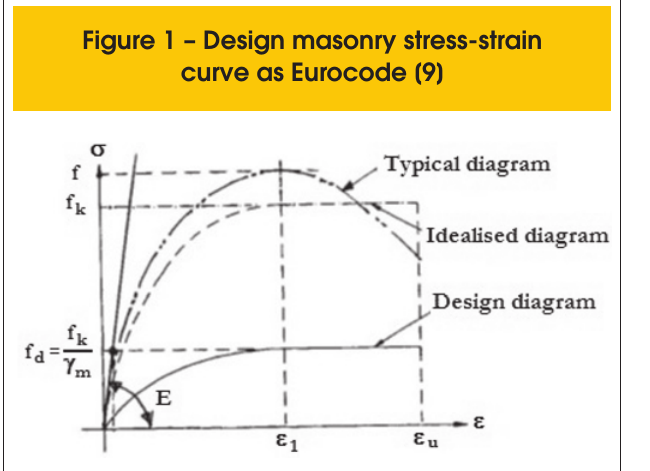
Figure 1 – Design masonry stress-strain curve as Eurocode [9]